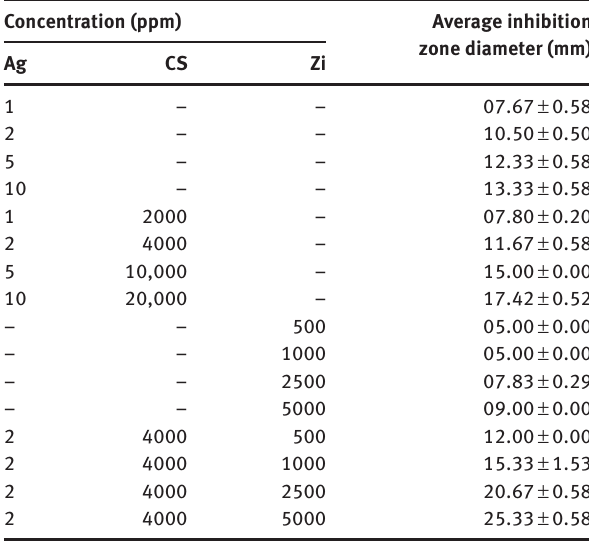
Table 1: The diameters of inhibited zone of Ag, Ag@CS, and Ag@CS-Zi. Concentration (ppm)